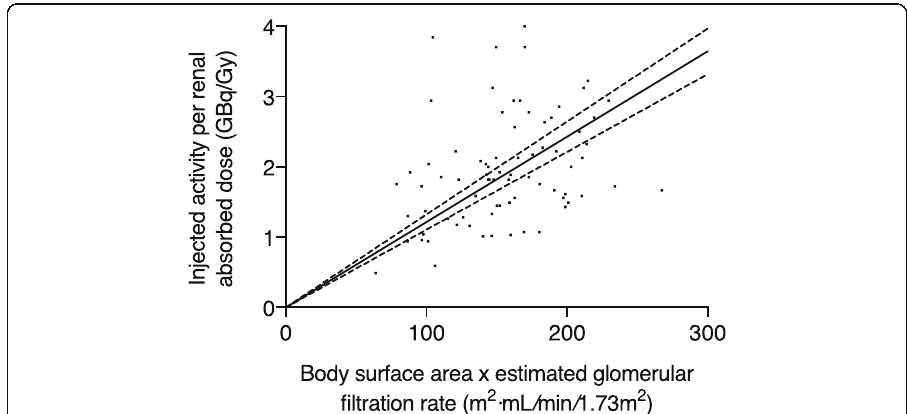
Fig. 5 Injected activity per renal absorbed dose at the first cycle vs. the product of body surface area and estimated glomerular filtration rate ( n = 77). There was a moderate correlation between variables (Spearman r =0.39, P =0.0005). The slope of the linear regression curve forced through origin (solid line; 95% confidence interval, dashed lines), which was 0.012 GBq · min × 1.73/mL / Gy, is to be used to adjust the injected activity